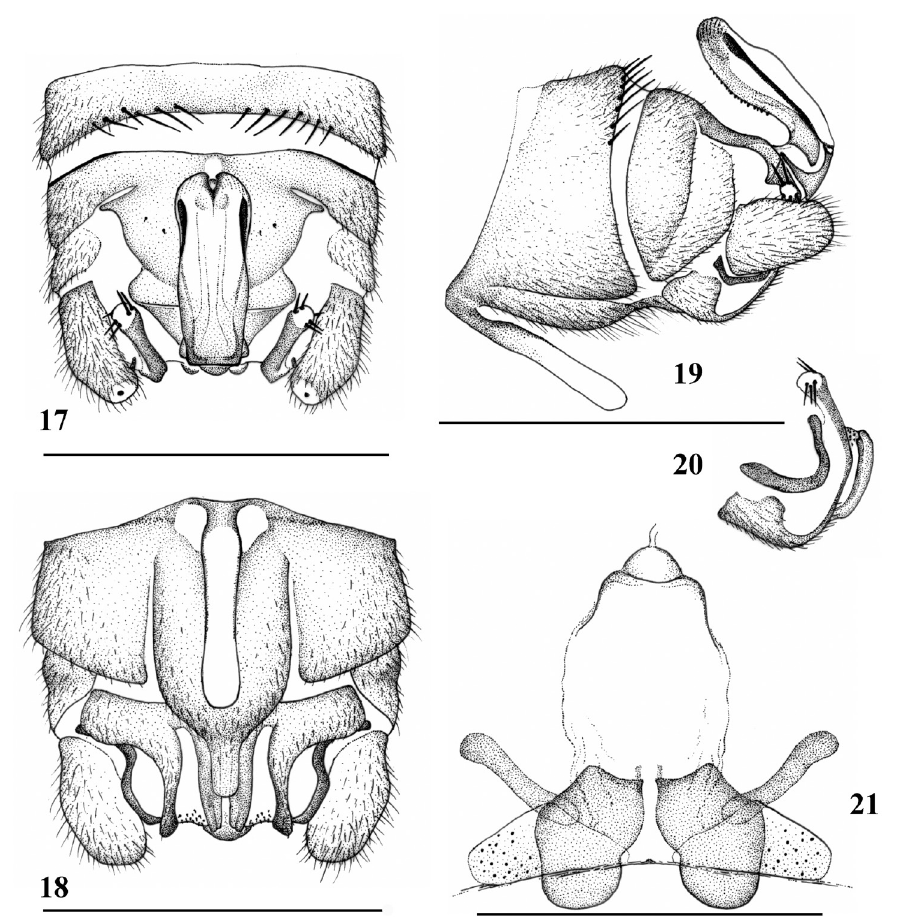
Figures 17–21. Amphinemura dingoidea sp. n., terminalia of the adult paratypes. 17 Male terminalia, dorsal view 18 Male terminalia, ventral view 19 Male terminalia, lateral view 20 Male paraproct, oblique lateral view 21 Female inner genitalia, dorsal view. Scale bar: 0.5 mm.